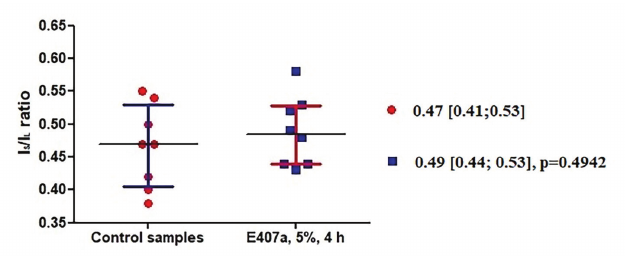
Figure 3. The ratio of the intensities of the most short-wavelength fluorescence band and the most long-wavelength fluorescence band (IS/IL) of probe PH1 in leukocyte suspensions treated and untreated with the food additive E407a